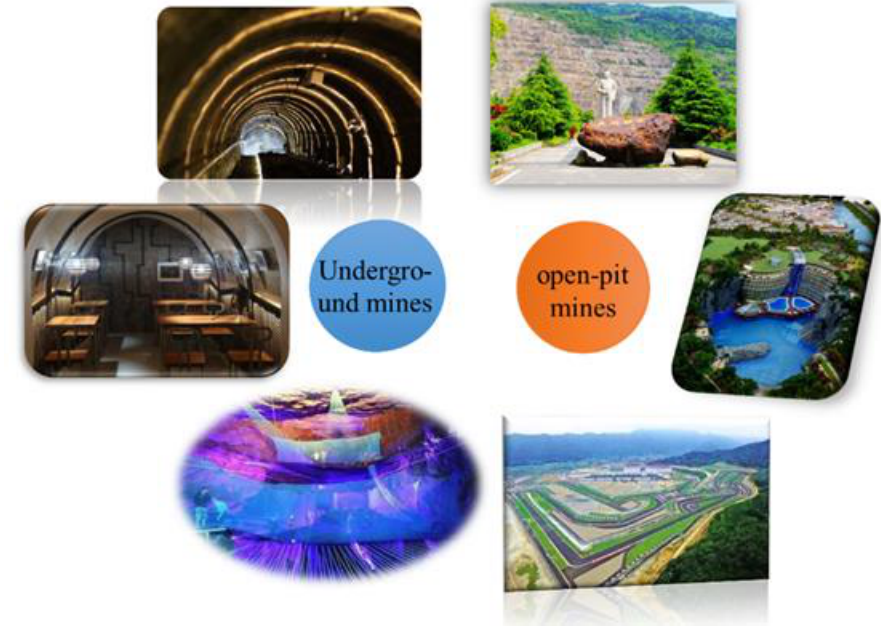
Figure 9. Ecological development model of abandoned mines.